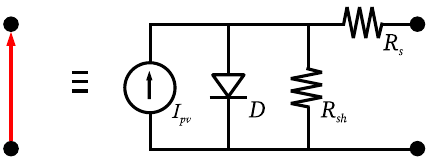
Figure 7. An arc in the array-digraph is translated using ODM to NgSpice